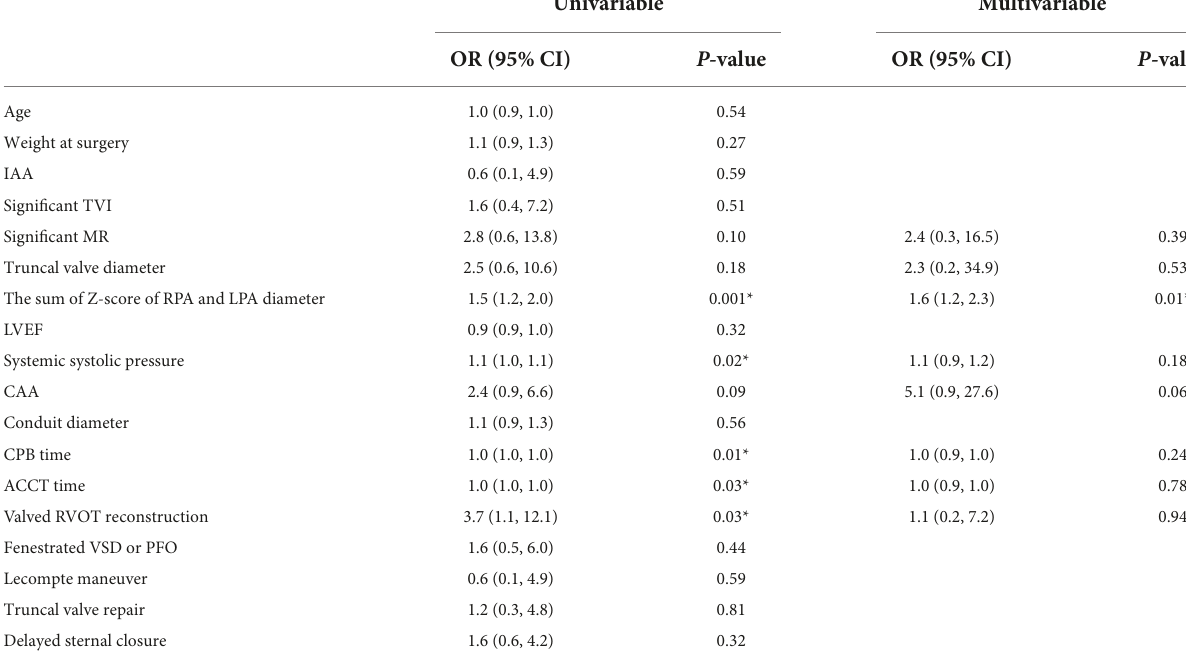
TABLE 5 Univariable and multivariable analysis for risk factors of post-operative PHC occurrence by logistic